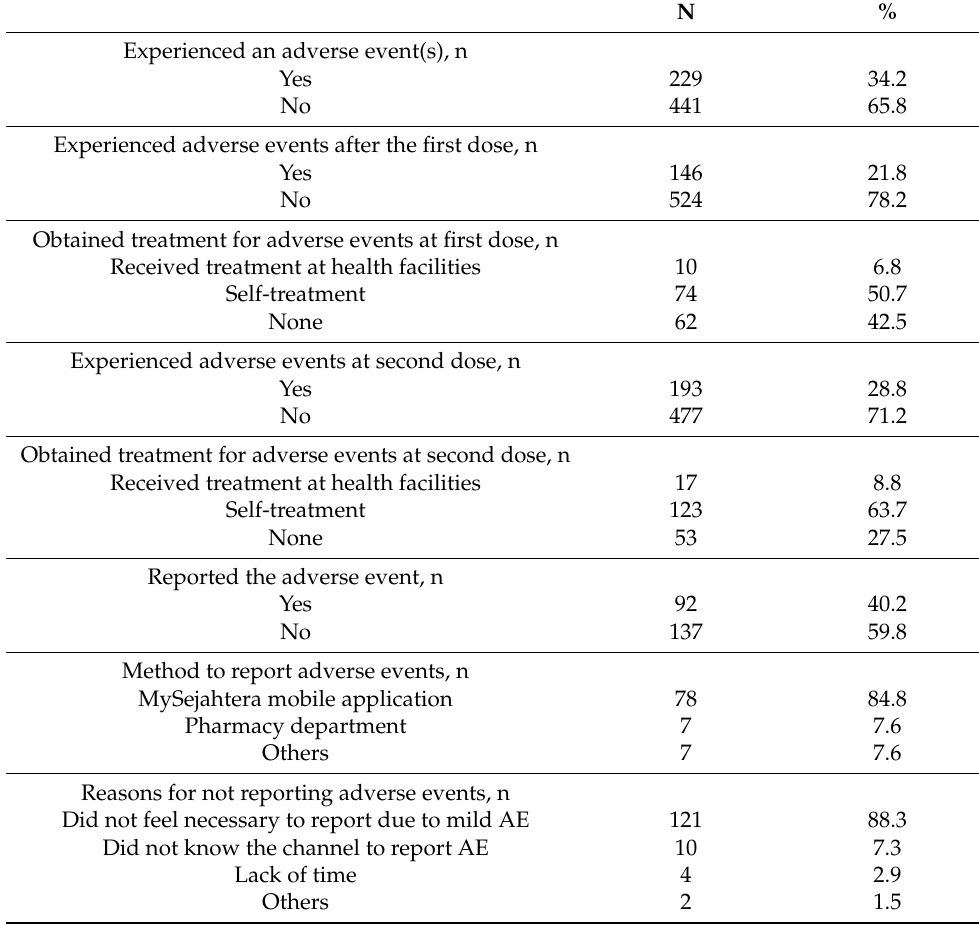
Table 2. Adverse events, management and reporting (n =